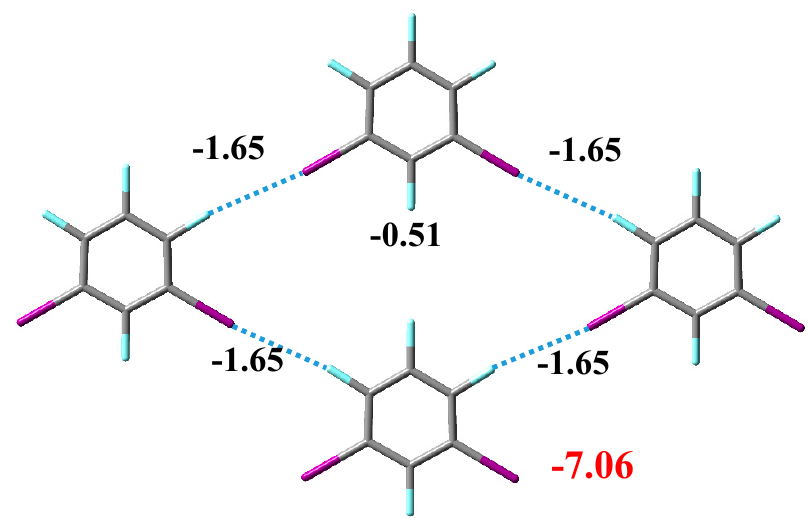
Figure 5. The four 1,3-DITFB molecules involved in a C–I···F halogen-bonded loop. The black numbers (in kcal/mol) are the interaction energies of two neighboring molecules, and the red number (in kcal/mol) is the total interaction energy of the tetramer.